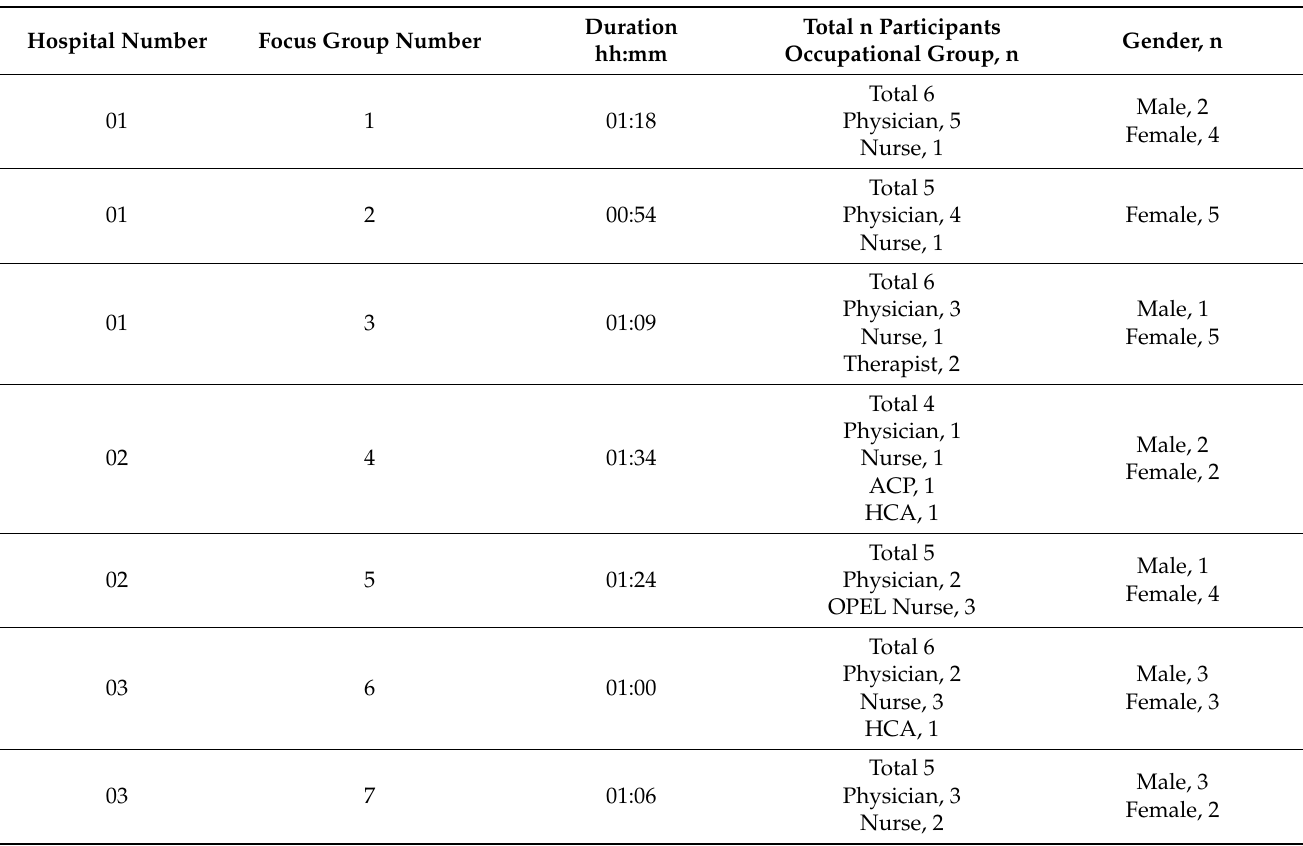
Table 2. Focus group